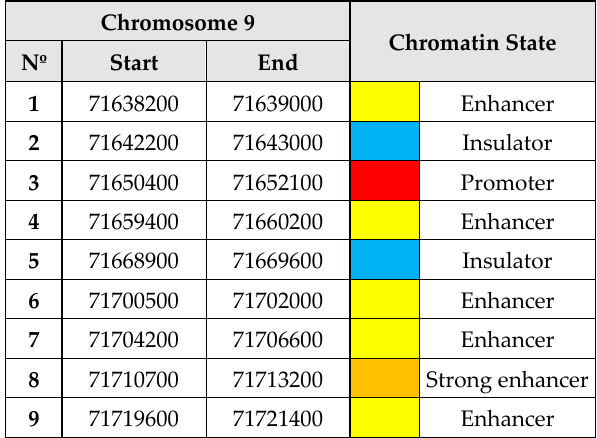
Table 1. Putative regulatory regions in the FXN genomic locus and associated chromatin state provided by ENCODE.